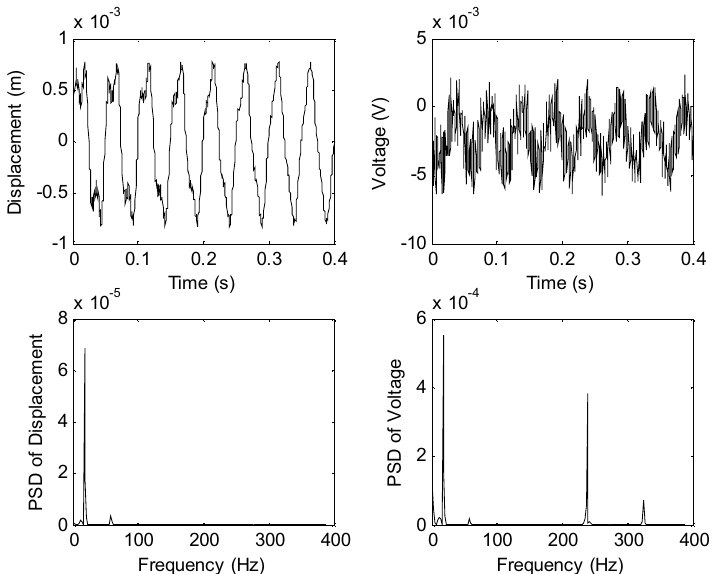
Fig. 23. Steady-state time history and frequency spectrum plots for vertical blade tip displacement and PZT sensor voltage at f = 20 Hz. Sinusoidal vertical step forces are acting in the middle and at the tip of the blade with respective frequencies of 20 Hz and 240 Hz.